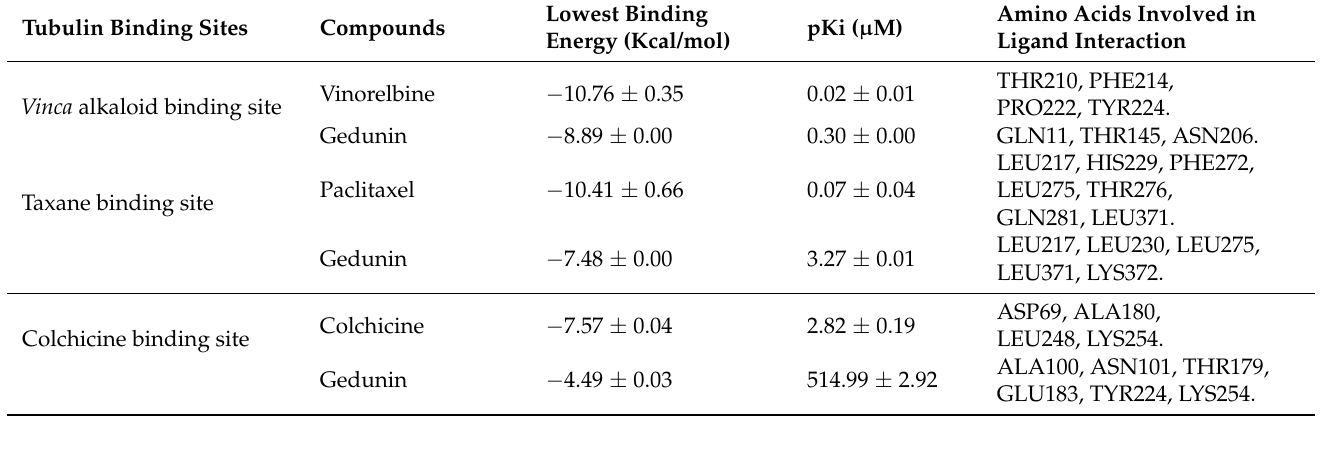
Table 3. Molecular docking of gedunin to three different drug-binding sites of β -tubulin. Shown are the lowest binding energies (kcal/mol), predicted inhibition constants ( µ M), and amino acids involved in the ligand interaction of gedunin in comparison to the control drugs vinorelbine, paclitaxel, and colchicine, which are known to bind to the three binding sites.